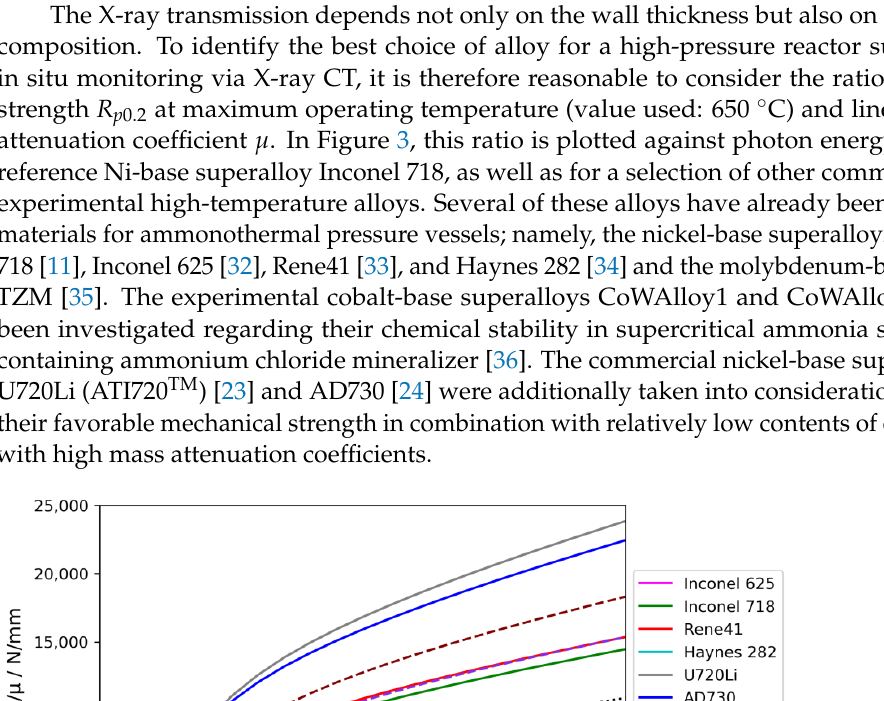
(i.e., a radiographed thickness of 2 t ) as a function of photon energy.